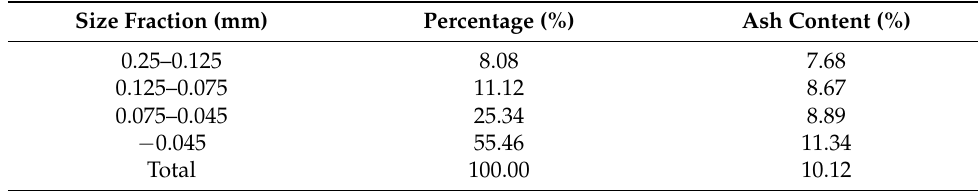
Table 2. Particle size distribution of LRC